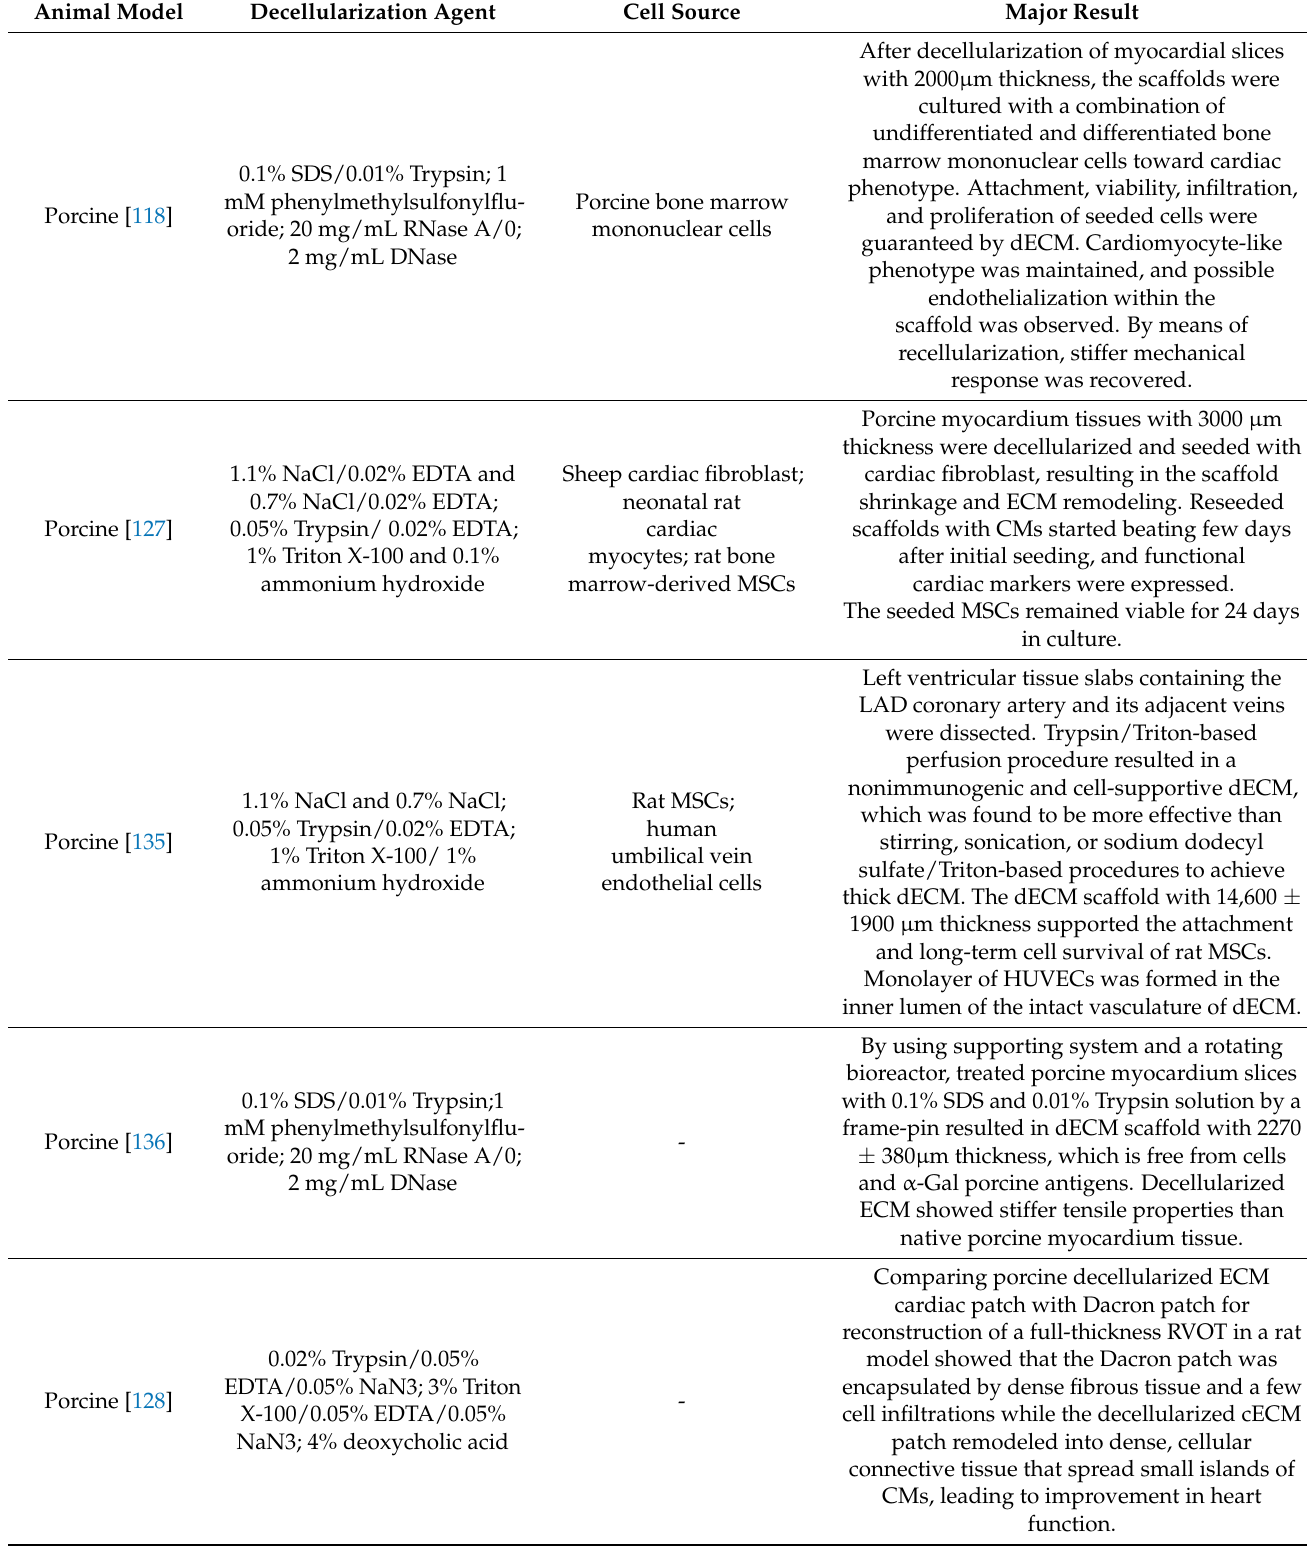
Table 5. Porcine and ovine natural myocardial ECM used for cardiac